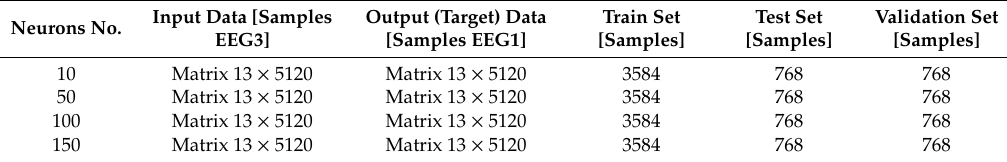
Figure 8. Artificial neural network (ANN) with n neurons, n ∈ {10, 50, 100, 150}. In Table 1, the principal parameters for ANNs with 10, 50, 100, and 150 neurons are presented. Table 1. ANN